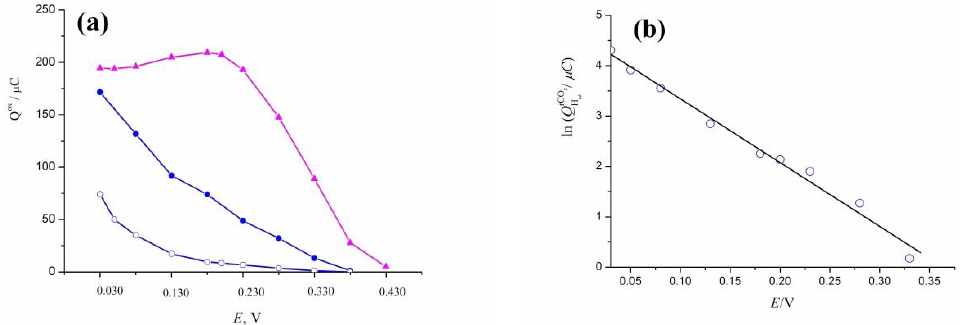
Figure 6. Charges ( a ) Q ox of the oxidation: magenta triangles: Q rCO Q rCO 2 . Charges ( b ) of the H ad oxidation in the presence of rCO 2 in lnQ rCO 2